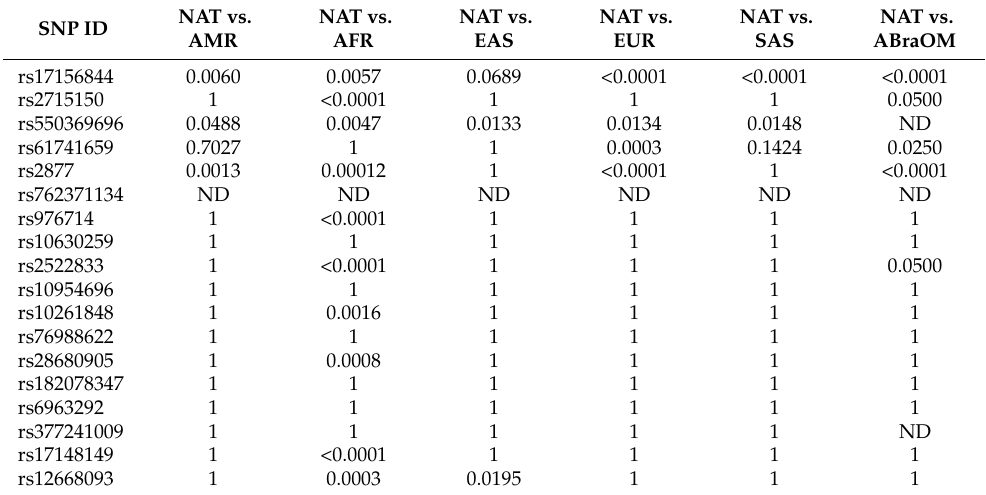
Table 4. Pairwise comparison ( p -value) of allelic frequencies in Amerindians and with each one of the five continental populations from 1000 Genomes and the Brazilian population from ABraOM for each PCLO gene variant